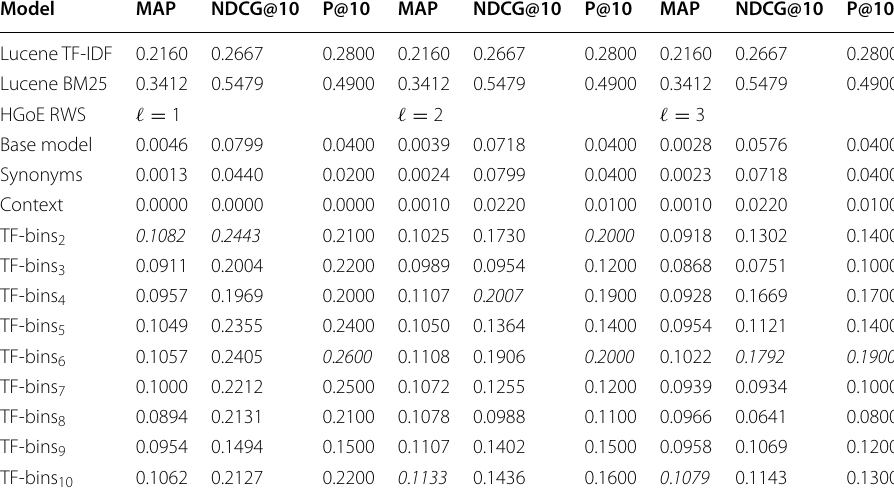
Table 6 Evaluating the different models in the ad hoc document retrieval task Model MAP NDCG@10 P@10 Lucene TF-IDF 0.2160 0.2667